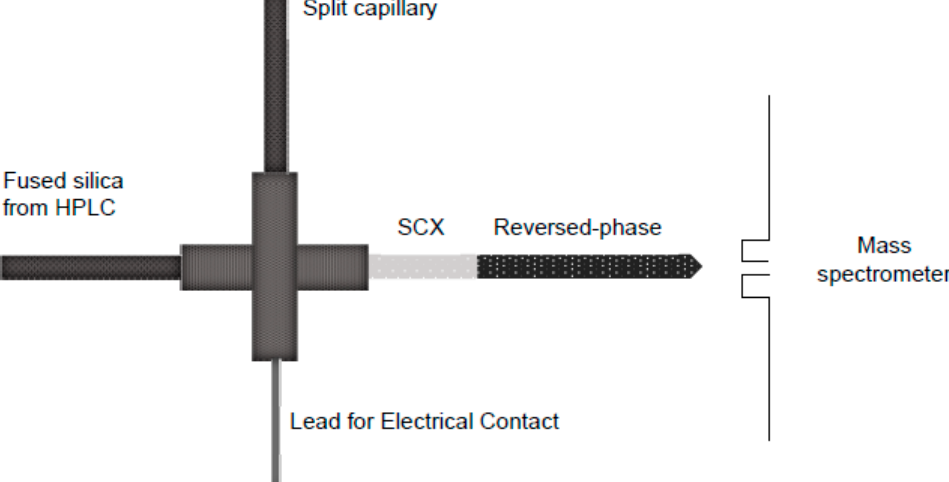
Figure 3. Multidimensional protein identification technology (MudPIT) for the separation of complex proteome samples. MudPIT consists of a biphasic column packed with strong cation exchange (SCX) and reversed-phase resins. Peptides derived via a tryptic digest of a proteome sample are loaded onto the SCX resin and eluted using a step gradient of increasing salt concentrations onto the reversed-phase column. The peptides are eluted from the reversed-phase column using a linear gradient directly into the mass spectrometer for identification. Repeated cycles of this process using increasing salt concentrations enables the peptides to be separated providing the mass spectrometer more opportunity to identify a greater number of peptides. Adapted from